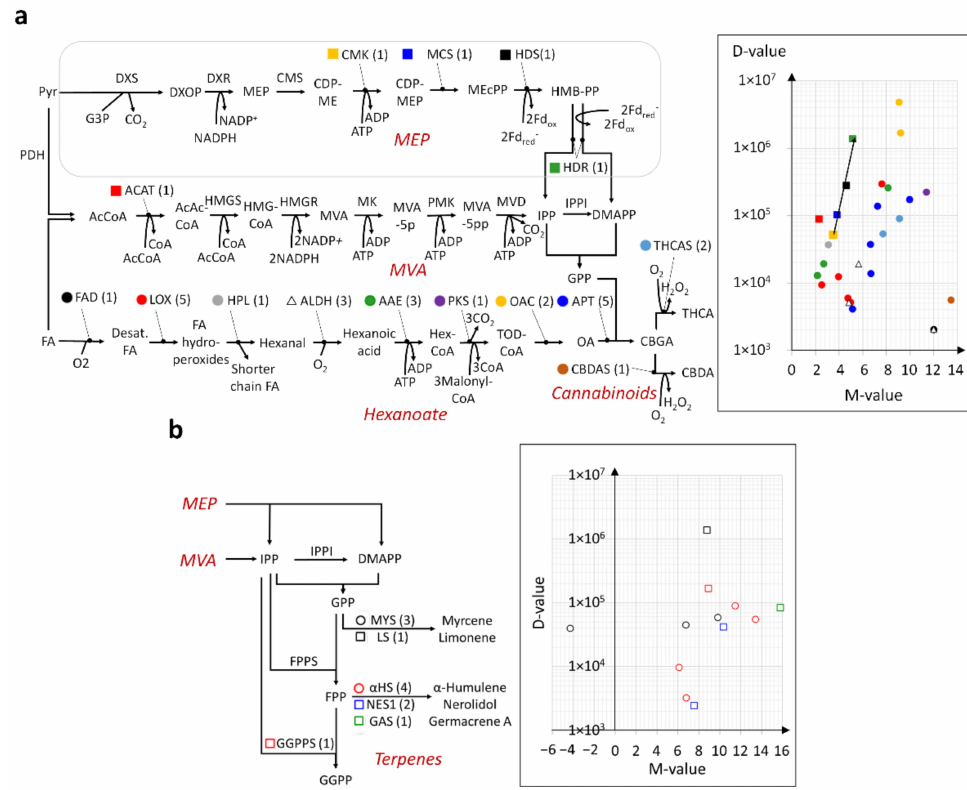
Figure 3. Distinct mode of transcriptional regulation for secondary metabolite biosynthetic path- ways. ( a ) M-D plot of DEGs (trichomes versus stem tissue) in the MEP, MVA, hexanoate, and cannabinoid pathways, with corresponding enzyme names being similarly color-coded in the path- way schematic on the left. The numbers inside brackets indicate the numbers of DEGs. Note that the black arrow in the M-D plot illustrates the increasing gene regulation at the end of the MEP pathway. ( b ) Similar M-D plot and corresponding enzyme names in the context of the terpene biosynthetic pathways. Refer to Table S8 for corresponding gene IDs of enzymes. Enzyme abbrevia- tions for MEP pathway (left to right): DXS (DOXP synthase); DXR (DXP reductoisomerase); CMS (2-C-methyl- D -erythritol 4-phosphate cytidylyltransferase); CMK (4-diphosphocytidyl-2-C-methyl- D -erythritol kinase); MCS (2-C-methyl- D -erythritol 2,4-cyclodiphosphate synthase); HDS (HMB-PP synthase); HDR (HMB-PP reductase), MVA pathway (left to right): ACAT (acetyl-coenzyme A acetyltransferase); HMGS (HMG-CoA synthase); HMGR (HMG-CoA reductase); MK (mevalonate- 5-kinase); PMK (phosphomevalonate kinase); MVD (mevalonate-5-pyrophosphate decarboxylase); IPPI (isopentenyl diphosphate isomerase); GPPS (GPP synthase), Hexanoate pathway (left to right): FAD (fatty acid desaturase); LOX (lipoxygenase); HPL (hydroperoxide lyase); ALDH (aldehyde dehydrogenase); AAE (acyl activating enzyme); PKS (polyketide synthase); OAC (olivetolic acid cyclase), Cannabinoid pathway : APT (aromatic prenyl transferase); THCAS (THCA synthase); CB- DAS (CBDA synthase), Terpene pathway (top to bottom): MYS (myrcene synthase); LS (limonene synthase); FPPS (Farnesyl diphosphate synthase); α HS ( α -humulene synthase); NES1 (nerolidol syn- thase); GAS (Germacrene A synthase); GGPPS (geranylgeranyl diphosphate synthase). Metabolite abbreviations in numeric and alphabetical order: AcCoA (Acetyl co-enzyme A); AcAcCoA (Ace- toacetyl CoA); ADP (adenosine diphosphate); ATP (adenosine triphosphate); CBDA (cannabidiolic acid); CBGA (cannabigerolic acid); CDP-ME (4-diphosphocytidyl-2-C-methylerythritol); CDP-MEP (4-diphosphocytidyl-2-C-methyl- D -erythritol 2-phosphate); CoA (coenzyme A); DMAP (Dimethylal- lyl pyrophosphate); DXOP (deoxyxylulose 5-phosphate); FA (fatty acids); F dox (oxidized ferredoxin); Fd red- (reduced ferredoxin); FPP (Farnesyl diphosphate); G3P (glyceraldehyde-3-phosphate);